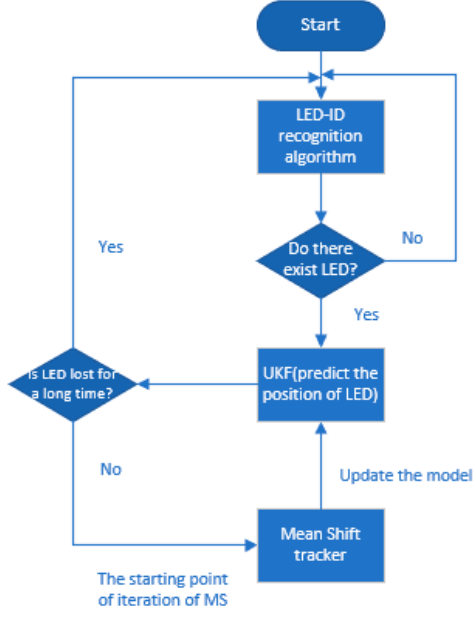
Figure 2. The flow of our proposed visible light positioning (VLP) algorithm.